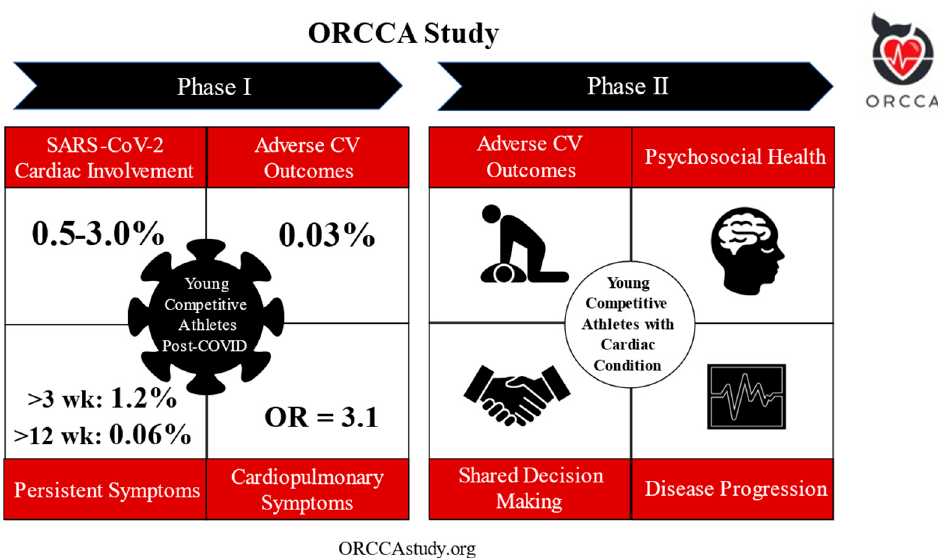
Figure 1. Overview of ORCCA Phase 1 and Phase 2. Reproduced from ACC.org [16]. Definition of abbreviations: OR = odds ratio. For Phase 1, the prevalence of SARS-CoV-2 cardiac involvement was found to be 0.5–3.0% [15]. On a median follow-up of >1 year ( n = 3675), there was one adverse event (0.03%) possibly related to SARS-CoV-2 infection [17]. The prevalence of persistent symptoms following SARS-CoV-2 infection >3 weeks was found to be 1.2%, and >12 weeks in 0.06% of athletes [18]. Cardiopulmonary symptoms were associated with SARS-CoV-2 cardiac involvement in multivariate analysis with odds ratio 3.1 [95% CI 1.2–7.7] [15]. Phase 2 focusses on “high-risk” cardiac conditions and aims to monitor for (1) cardiovascular outcomes; (2) the process and outcome of competitive sport eligibility decisions; (3) physical activity and exercise habits after diagnosis; (4) psychological impact, mental health, and quality of life of living with a cardiovascular condition; (5) rate and magnitude of disease progression; and (6) changes to or implementation of a specific emergency action plan at the athlete’s institution (see Future Aims section